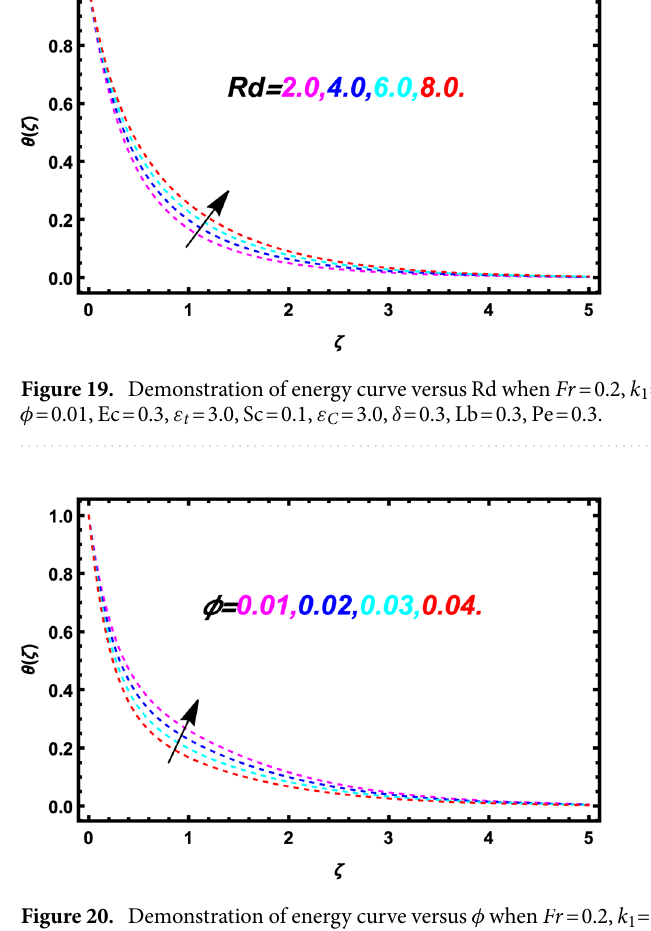
Figure 20. Demonstration of energy curve versus φ when Fr = 0.2, k 1 = 0.1, k 2 = 0.3, M = 0.5, m = 0.2, Pr = 5.3, Ec = 0.3, ε Rd = 0.2, Sc = 0.1, ε Lb = 0.3, Pe = 0.3. t = 3.0, C = 3.0, δ = 0.3,